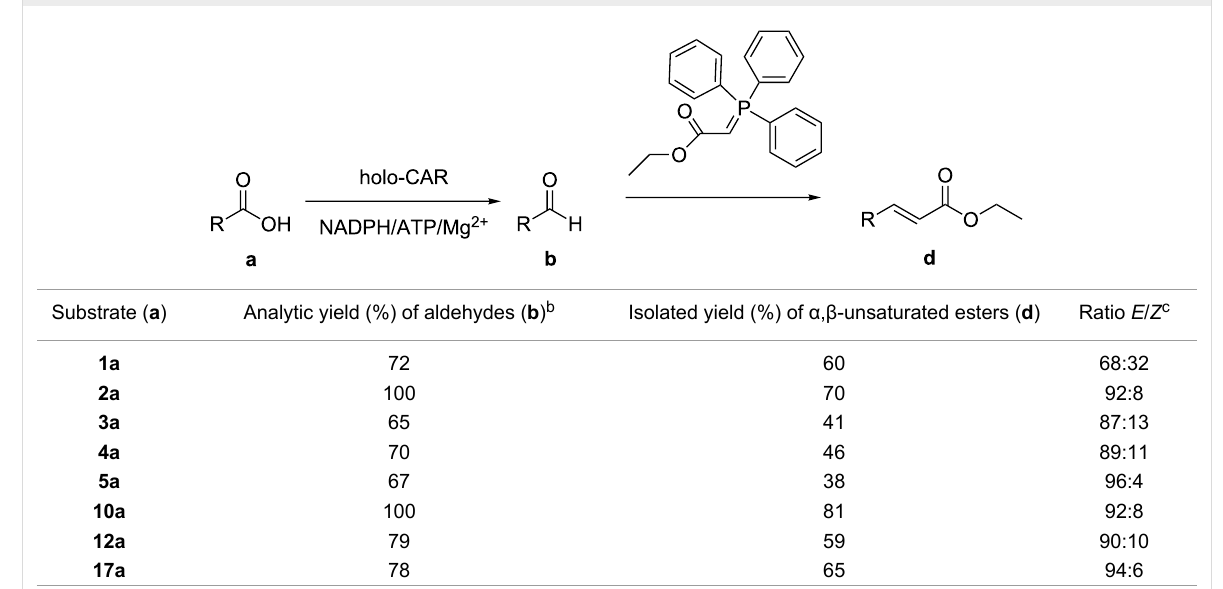
Table 3: Synthesis of α , β -unsaturated esters via enzymatic reduction and Wittig reaction a .